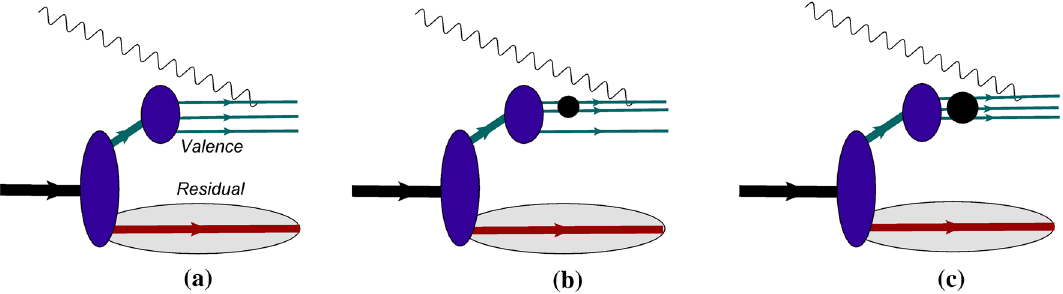
Fig. 1 The mean field ( a ), two-valence ( b ) and three-valence ( c ) quark short-range correlation contributions to the deep-inelastic scattering off the nucleon in the partonic